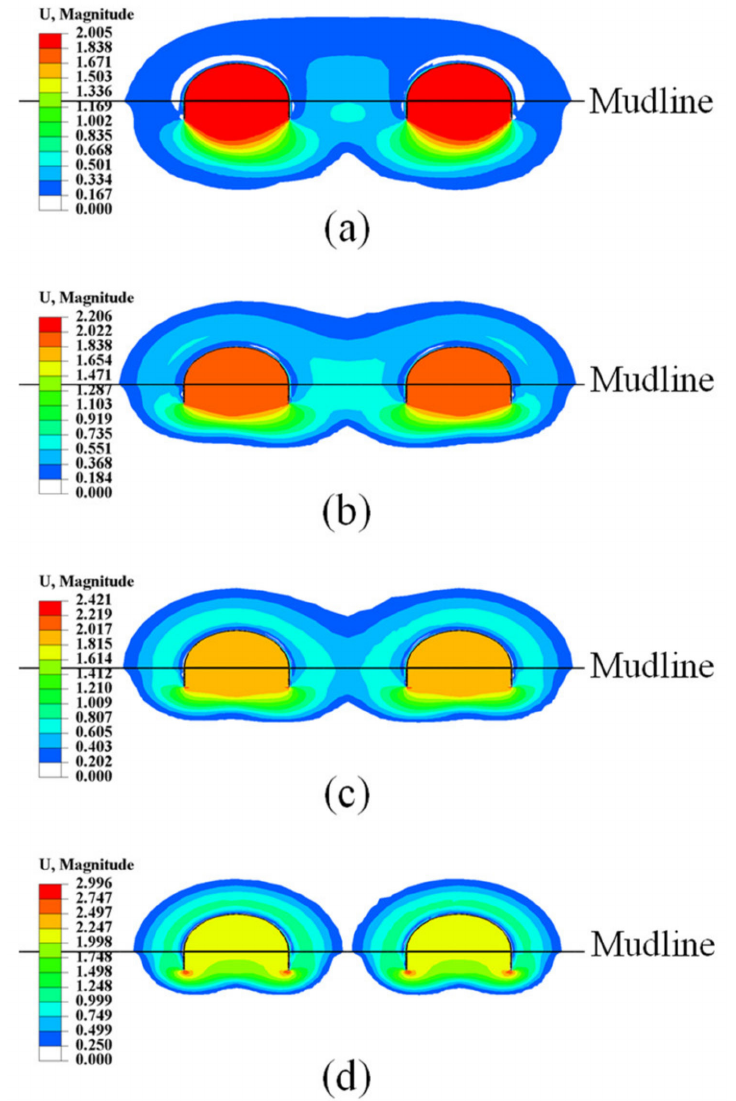
Figure 10. The magnitude of displacement contours of tetrapod bucket foundations and soils under ultimate vertical loading at s/D = 1.5 and d/D = 0.25 when ( a ) κ = 0, ( b ) κ = 1, ( c ) κ = 2 and ( d ) κ =